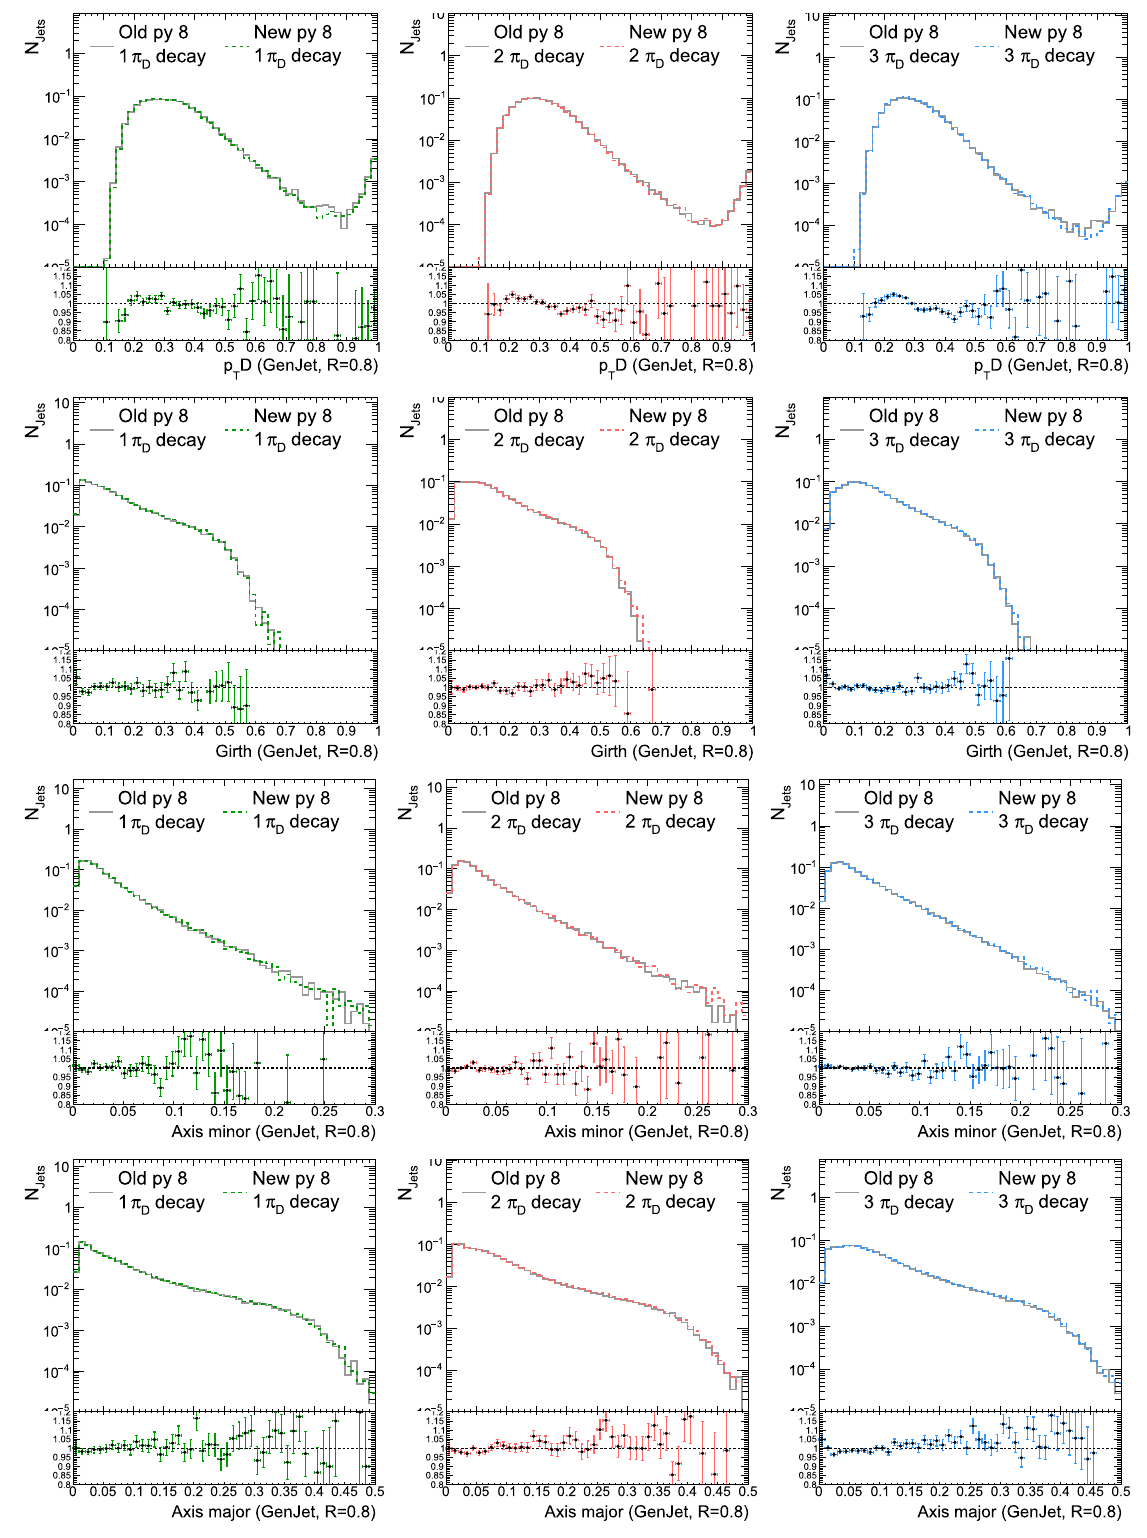
Fig. 39 Comparison of quark-gluon discriminant variables between old (grey solid line) and new (colored dashed line) Hidden Valley modules. The comparison is made for 1 (left), 2 (middle) and 3 (right) dark pions decay. The plotted ratio is the ratio of new to old pythia